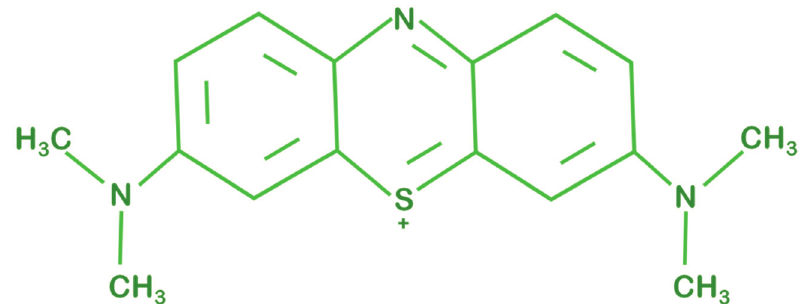
Figure 1. Methylene blue chemical